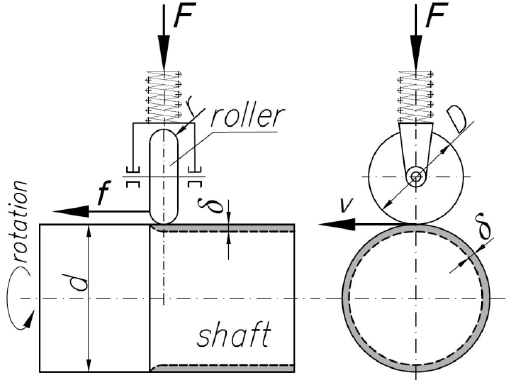
Figure 2. Schematic diagram and parameters of conventional roller burnishing.